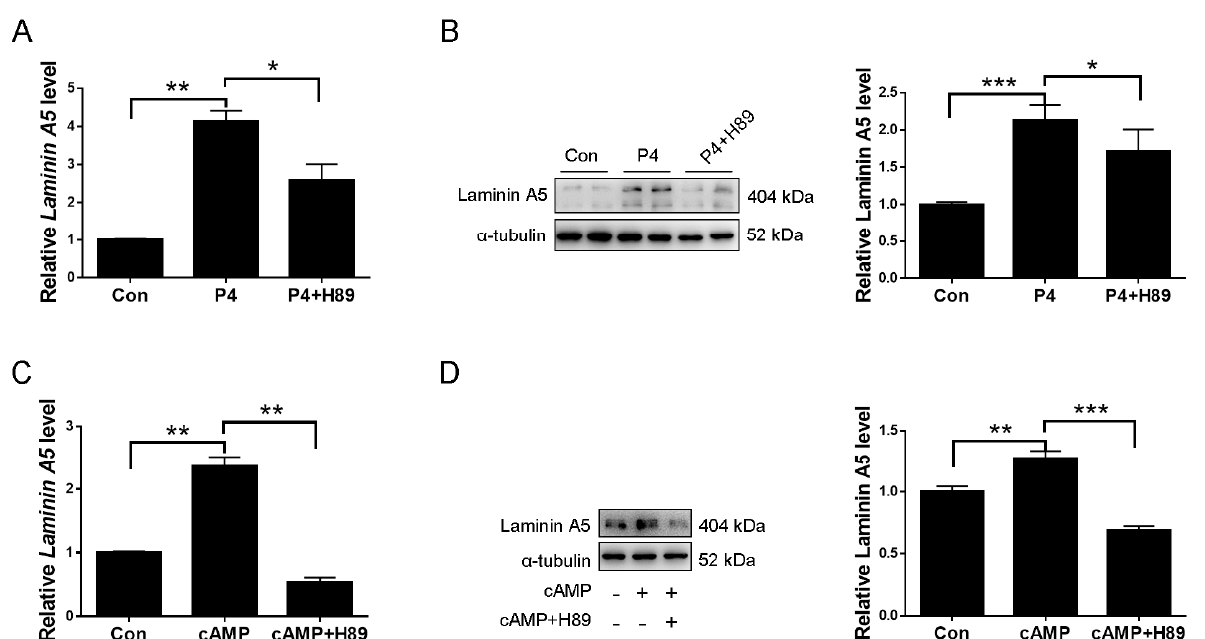
Figure 5. Progesterone regulates laminin A5 through the cAMP-PKA signal. ( A ) RT-qPCR analysis of effects of PKA inhibitor H89 on progesterone-induced Laminin A5 expression. ( B ) Western blot analysis of effects of H89 on progesterone-induced laminin A5 expression in stromal cells. ( C ) RT-qPCR analysis on effects of H89 on cAMP-induced Laminin A5 expression after stromal cells were treated with dB-cAMP. ( D ) Western blot analysis of effects of H89 on cAMP-induced laminin A5 expression. Bars represent mean ± SD (* p -value < 0.05, ** p -value < 0.01, *** p -value < 0.001).